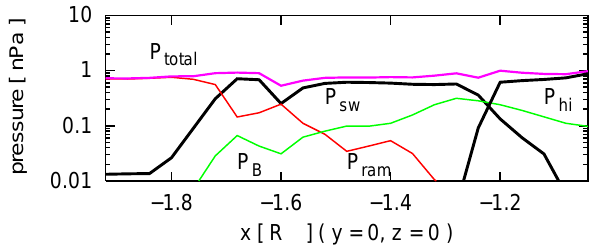
Fig. 14. The distribution of the kinetic pressure of the solar wind (P ram ), thermal pressure of the solar wind (P sw =P e , sw +P i ), ther- mal pressure of the heavy ion plasma (P hi =P e , hi +P hi ), and magnetic pressure (P B ) along the Sun-Mars line on the dayside for the “stan- dard run”. Parameters: see Fig.